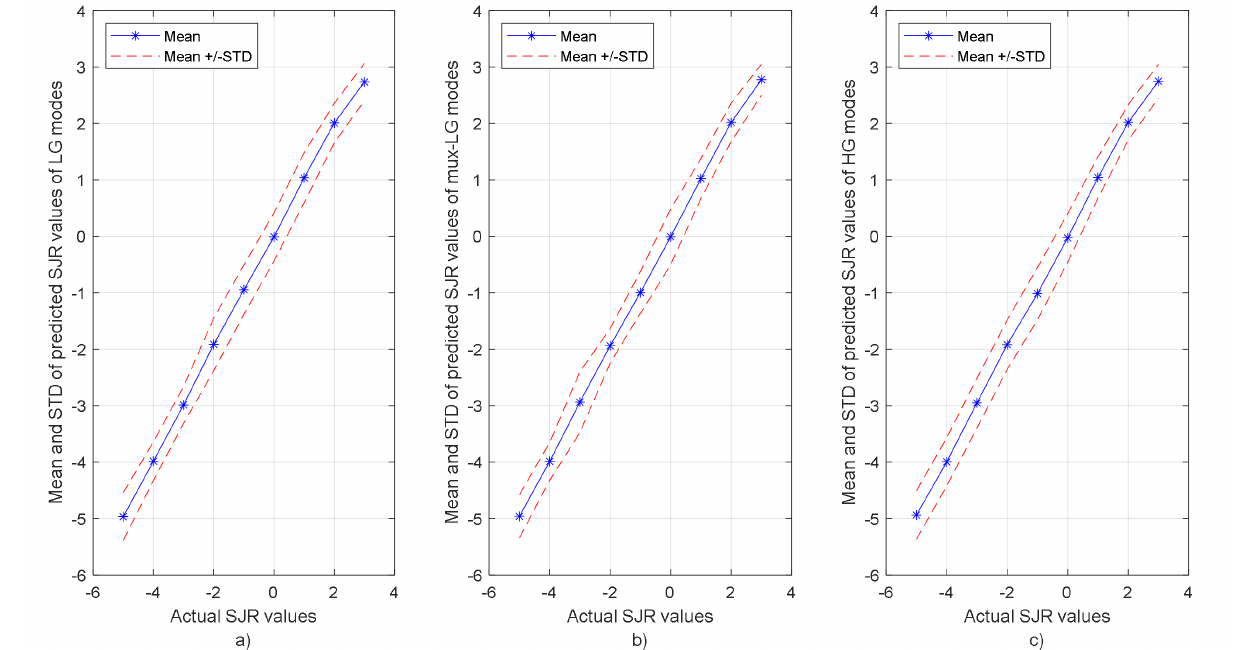
Figure 17. Mean ± STD of estimated SJR values over fifty independent runs for: ( a ) LG, ( b ) Mux-LG, and ( c ) HG